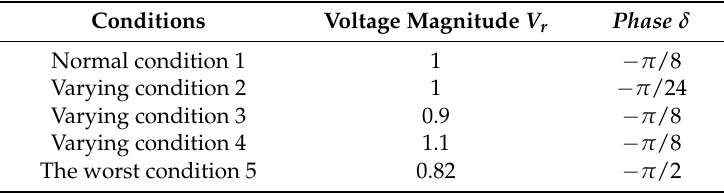
Table 1. The typical conditions set in power flow analyses.